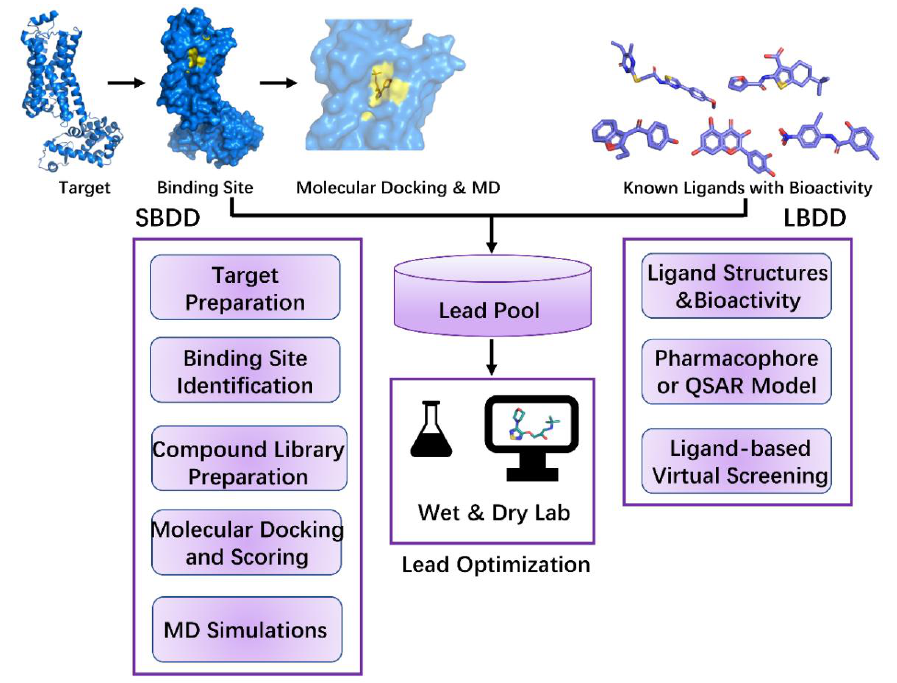
Figure 2. The workflow of structure-based drug design (SBDD) and ligand-based drug design